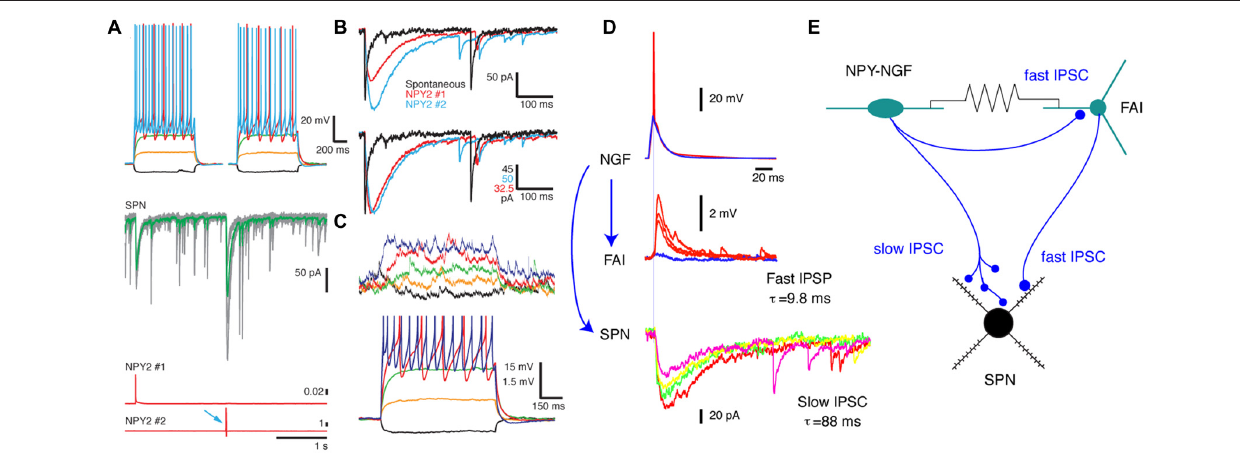
FIGURE 1 | Synaptic connections and electrotonic coupling of neurogliaform (NGF) interneurons. (A) Simultaneous triple recording from two neuropeptide Y (NPY)-NGF interneurons (top panels, whole cell current voltage series) and an spiny projection neuron (SPN) (middle, voltage clamp). Spikes elicited in the two NGF interneurons (botttom, red traces) evoke IPSCs in the SPN (middle, arrows; individual traces, gray; average, red). (B) Overlay of the average IPSCs elicited in the SPN (top) by the two interneurons (bottom panel: peak-scaled IPSCs). Note the nearly identical, characteristic slow time courses of the GABA Aslow IPSCs (blue and red). A regular, fast spontaneous GABA A IPSC is shown on the same scale (black) for comparison to illustrate the kinetic difference between the responses. (C) Electrotonic coupling between the same two NPY-NGF interneurons shown by membrane potential deflections in one neuron (top traces) induced by hyperpolarizing (black) and depolarizing potentials in the other neuron (bottom traces). Scale bar are the same for both NGFs. (D,E) Different triple whole cell recording illustrates complex interconnections of an NGF, fast adapting interneuron (FAI) and SPN. (D) The NGF (top) synapses onto both the FAI (middle) and the SPN (bottom). Note that while the synapse onto the SPN elicits a GABA Aslow IPSC, the synapse onto the FAI, arising from the same axon exhibits normal fast GABA A kinetics. (E) Schematics illustrating the connections of the three neurons. Panels (A–C) adapted from English et al.